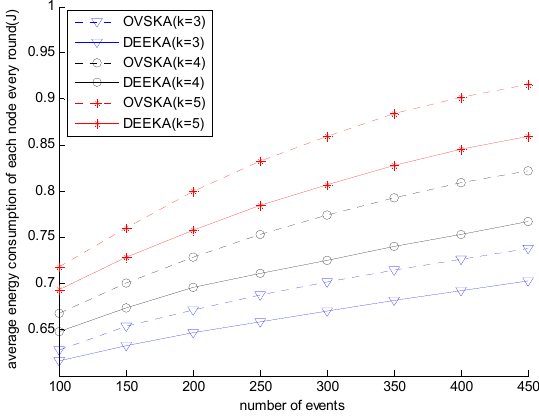
Figure 7. Average energy consumption of each node with event number and K-value.